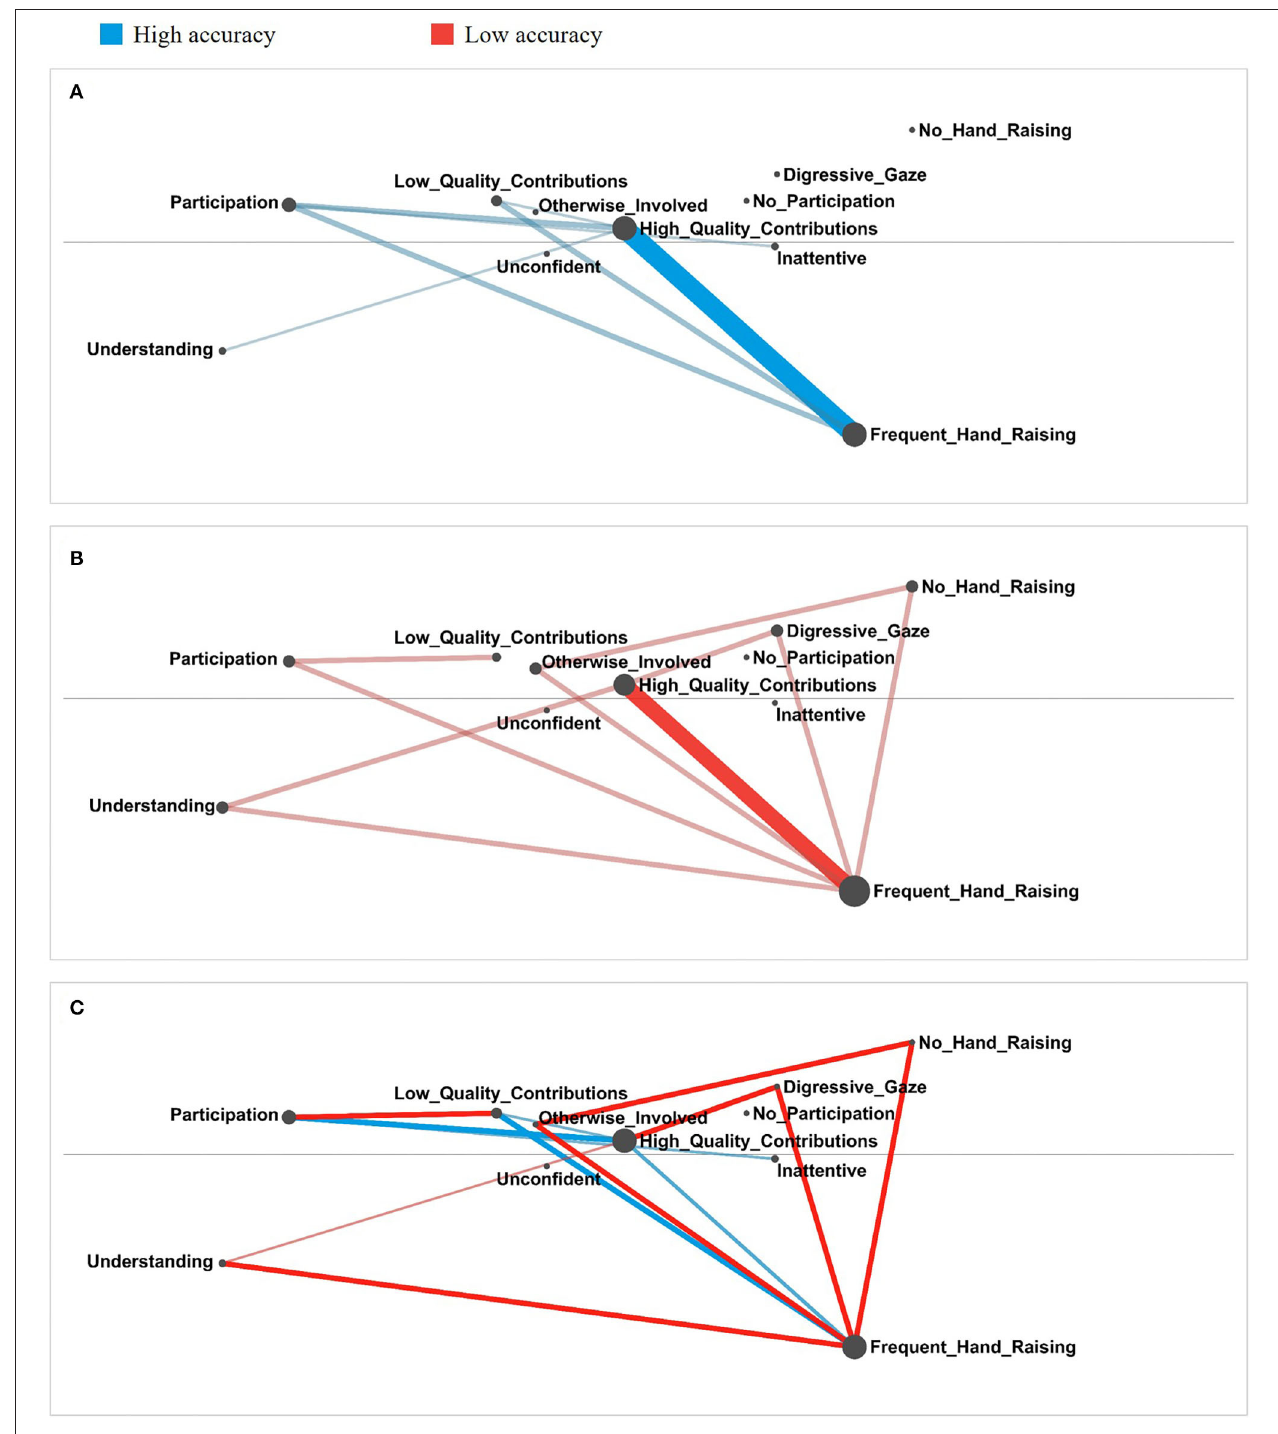
FIGURE 7 | Comparison of networks for strong student profile between student teachers with high and low judgment accuracy. (A) Depicts the network of the strong student profile for student teachers with high accuracy. (B) Depicts the network of the strong student profile for student teachers with low accuracy. (C) Shows the comparison of both networks. Here, the color of connections indicates which group utilized the respective code combination more frequently. In order to make the characteristics of the individual networks clearly visible and to make the differences visually easier to recognize, minimum edge weight and scale for edge weight were set to 0.1 and 1.3,